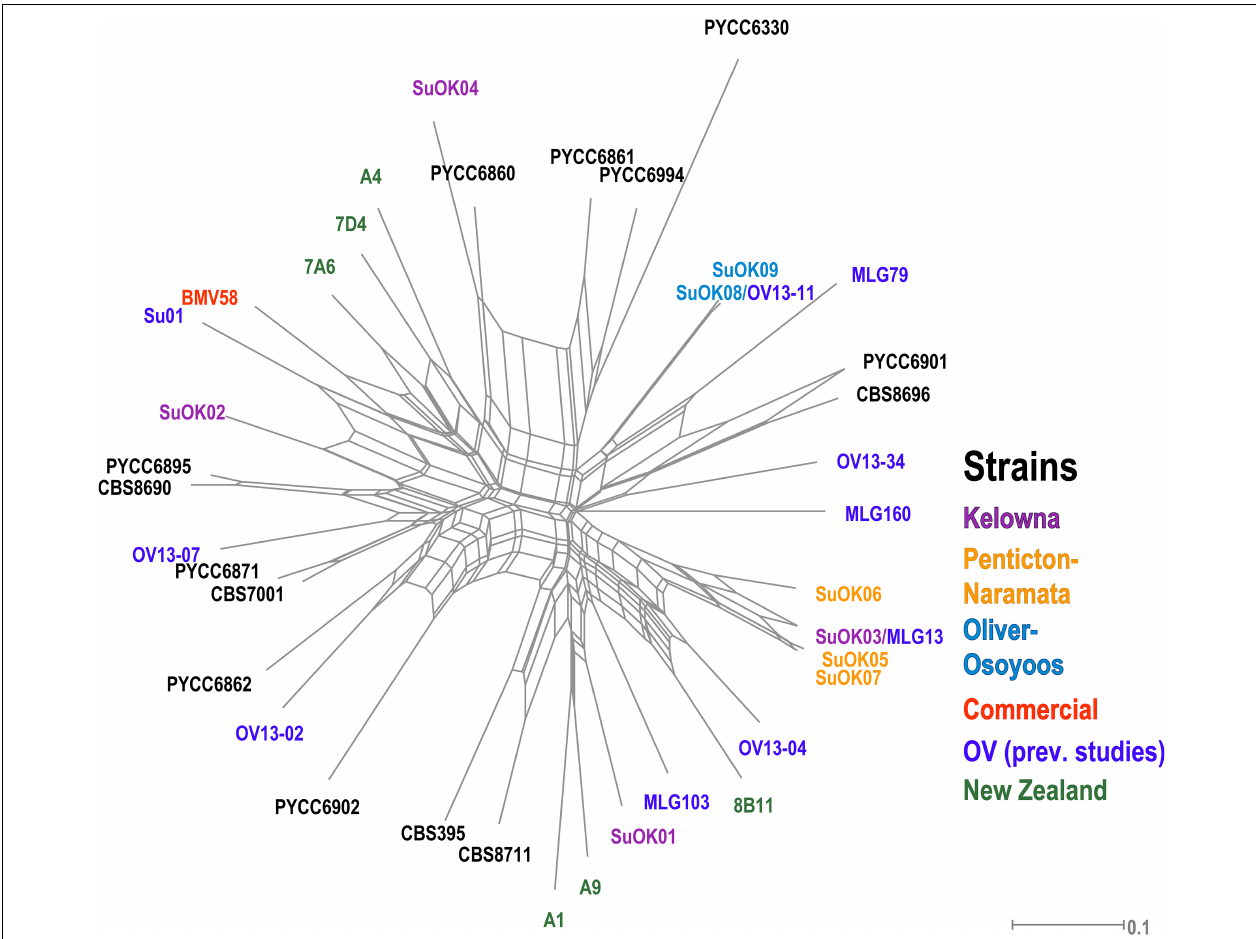
FIGURE 5 | Phylogenetic network of S. uvarum strains. The phylogenetic relationship was established by the Neighbor-Net algorithm based on BD. Newly discovered strains are labeled as “SuOK” and colored according to the region of isolation. SuOK08 and SuOK03 are indicated with strains isolated from the OV in previous studies (OV13-11 and MLG13, respectively, Supplementary Table S6 ). Green strains were isolated from a study in New Zealand (Zhang et al., 2015), the commercial S. uvarum strain BMV58 is indicated in red and black colored strains are from CBS and PYCC databases ( Supplementary Table S6